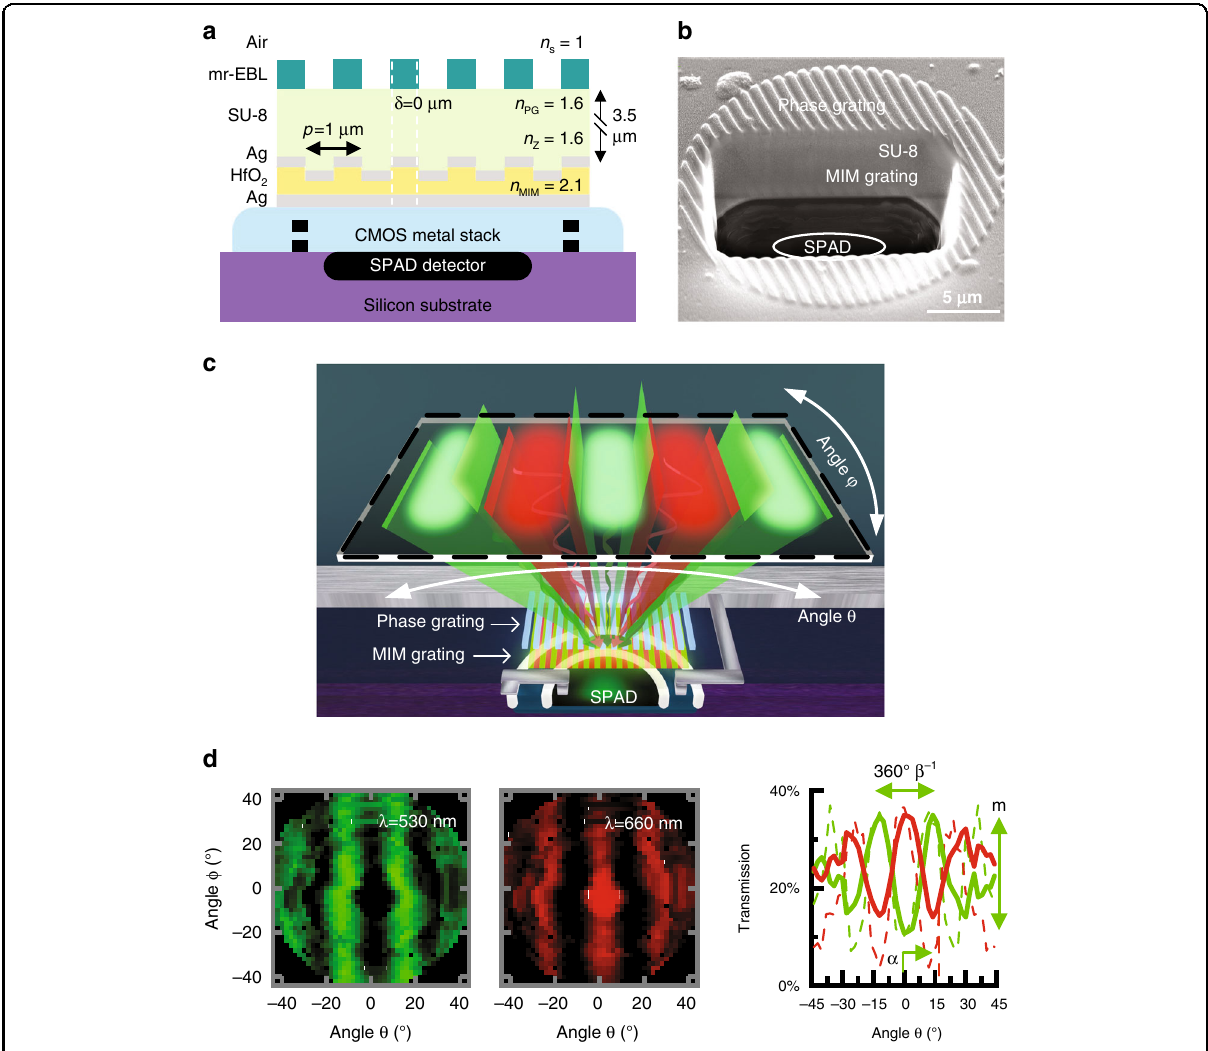
Fig. 2 MIMAS fi lter integrated on CMOS. ( a ) Fabrication of MIMAS on CMOS ( b ) FIB-SEM sideview showing front end fabrication, with annotations for SPAD, electrical contacts and CMOS metal stack. c The dual grating structure selectively transmits light according to incident angle, illustrating the point spread function from a single detector for either wavelength. d Two-dimensional angular response for a single device for both resonant wavelengths. A plot at φ = 0° compares measurement (solid) to simulation (dash). Resulting parameters of interest are the angular period 360° β − 1 , peak transmissivity offset from zero α , and modulation index